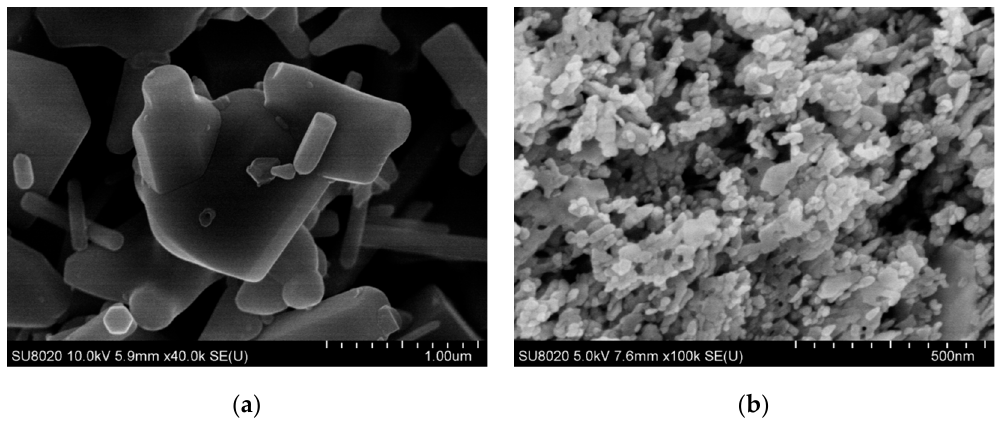
Figure 1. The SEM images of ( a ) micro-ZnO and ( b ) nano-ZnO pristine materials. Table 1. Sample nomenclature and compositions of di ff erent ZnO / LDPE